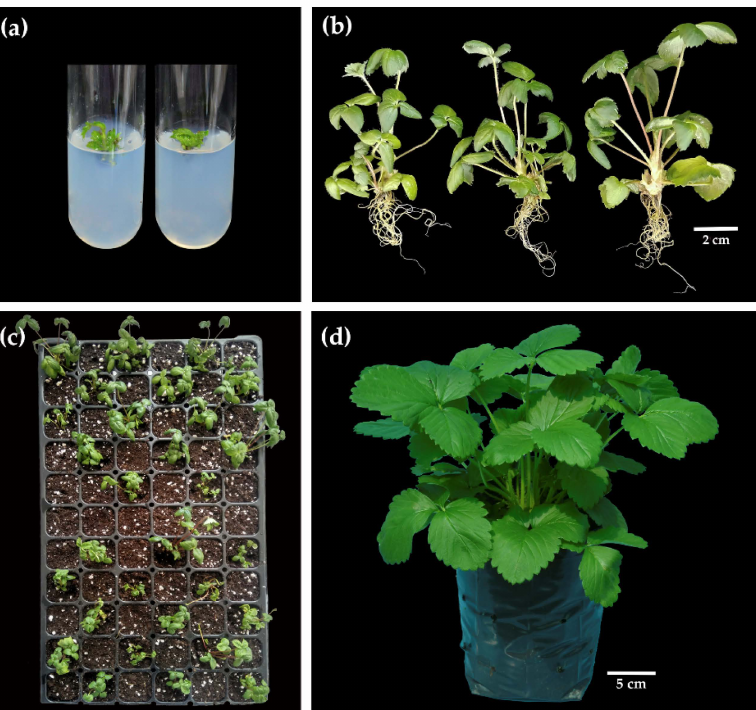
Figure 1. Micropropagation of strawberry variety ‘Aroma’: ( a ) meristems sprouted after 30 days in establishment medium; ( b ) explants developed after 45 days in multiplication medium, ready to be transferred to pre-acclimation; ( c ) seedlings in pre-acclimation; ( d ) plant after 50 days of